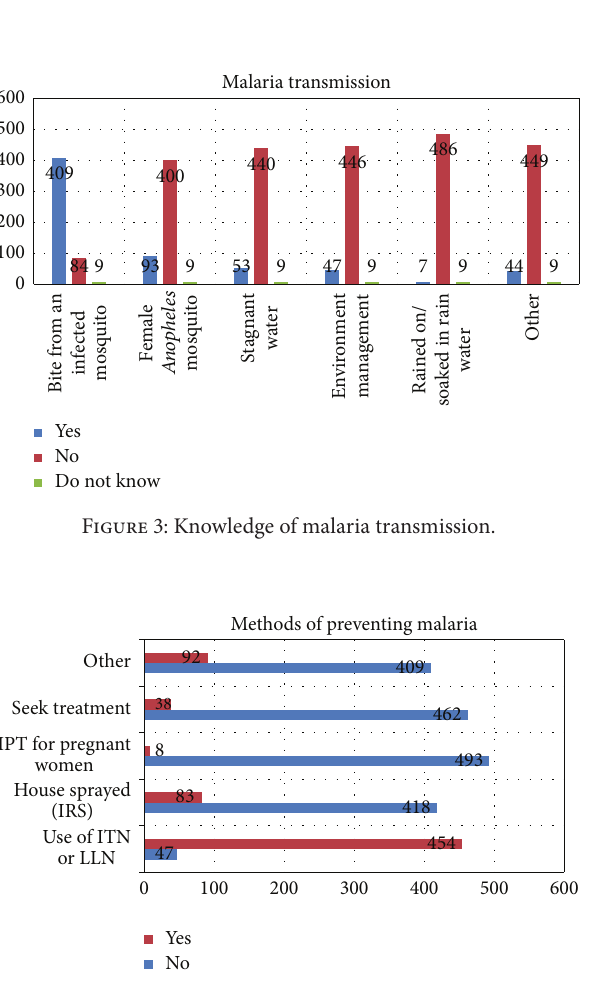
Figure 4: Methods of preventing